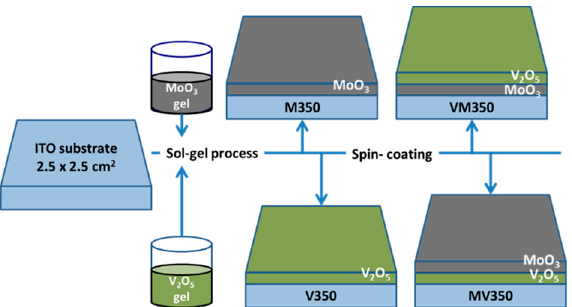
Figure 1. The schematic diagram of the preparation procedures for single-layered MoO 3 , V 2 O 5 , and MoO 3 / V 2 O 5 hybrid nanobilayers.